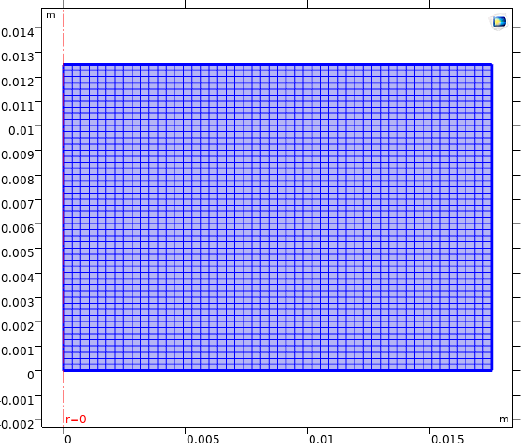
Figure 3. The computational mesh of the COMSOL Multiphysics model.